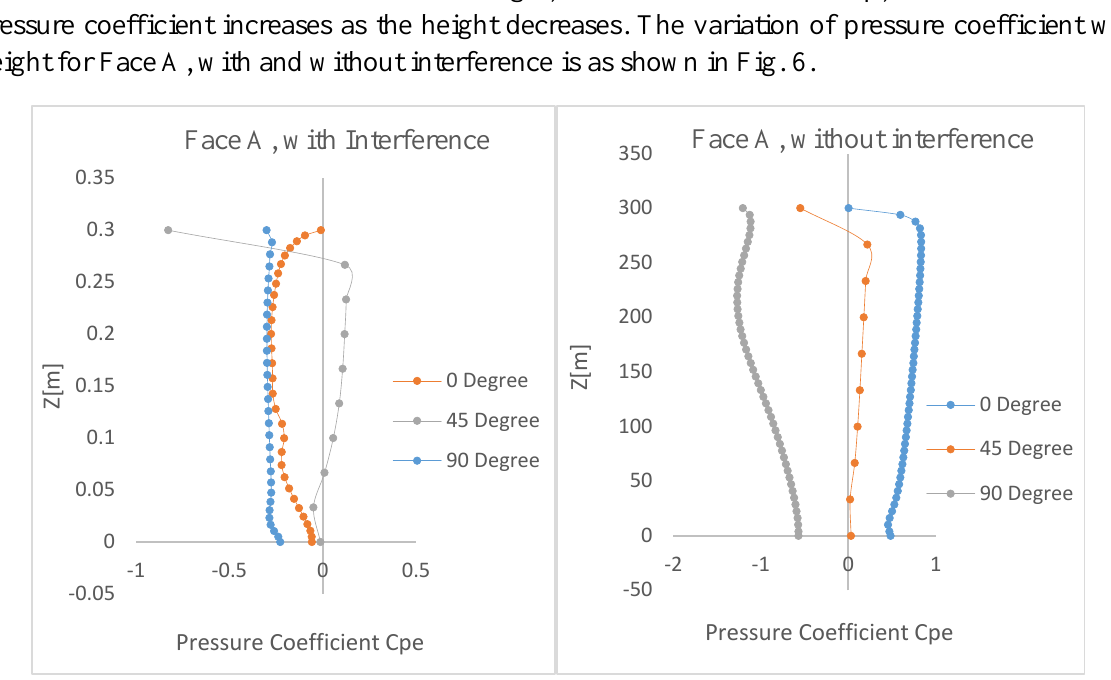
Fig. 6. Variation of pressure coefficient with height for Face A with Interference and without